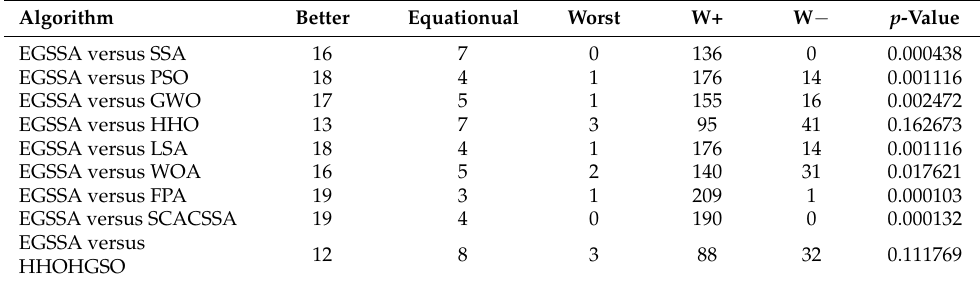
Table 5. The results of the statistical test.